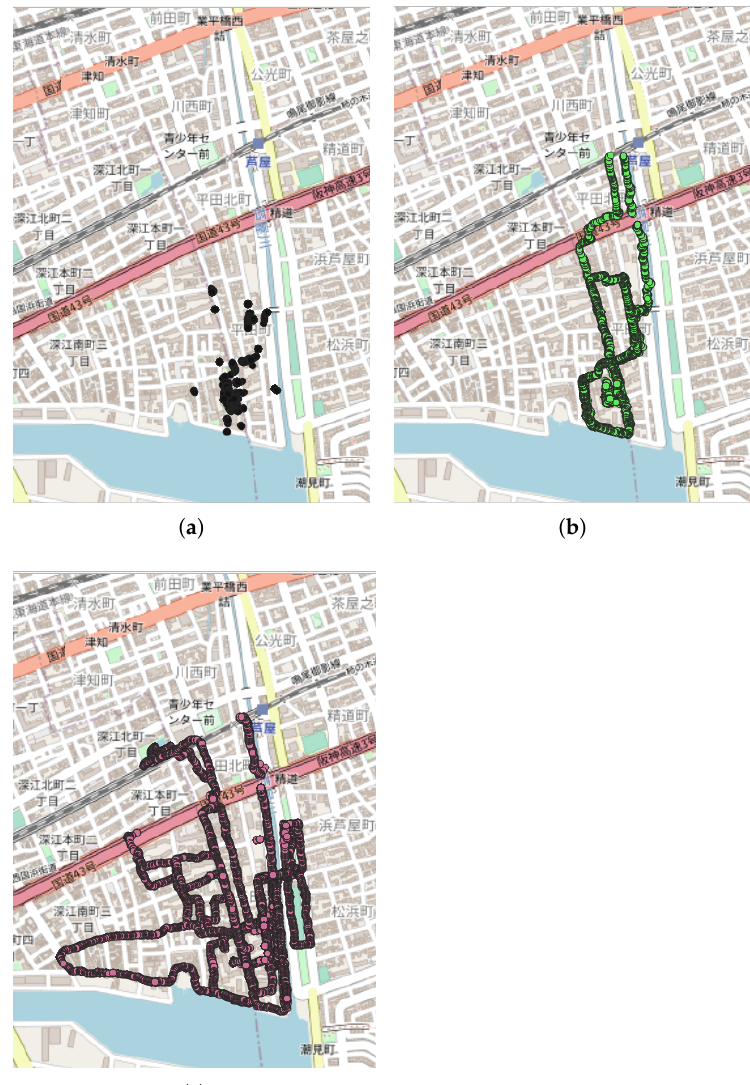
Figure 11. Representation of the clusters found in Kobe (Japan), in 2020; represented area of approxi- mately 1.3 km × 1.05 km: ( a ) representation of the measurements carried out during the event [44] in May 2020 (190 tracks, 3850 points); ( b ) [representation of the measurements carried out by the same users of the event [44]. July 2020 (28 tracks, 7778 points); ( c ) representation of the measurements carried out by the same users of the event [44] in August 2020 (12 tracks, 15,928 points). All the data are extracted from the NoiseCapture database